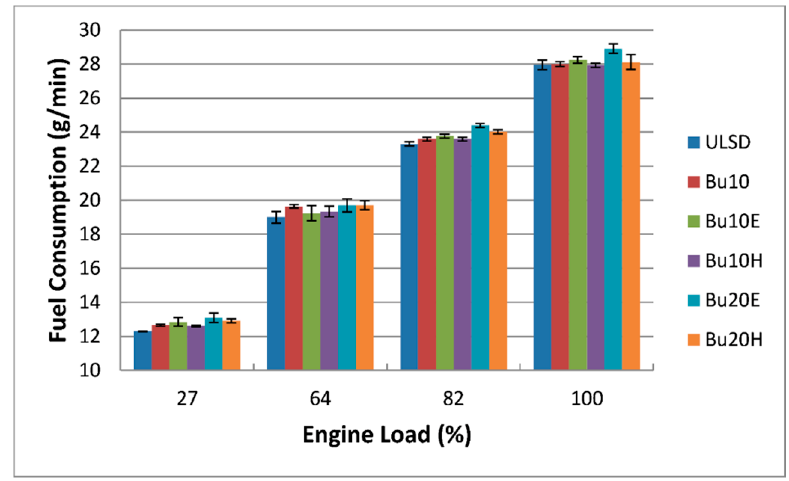
Figure 8. Gravimetric fuel consumption of the six fuels with the same DCN.